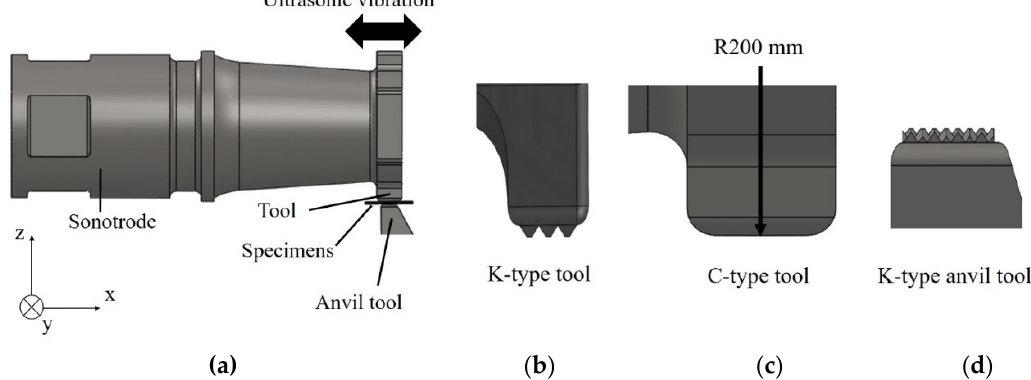
Figure 2. Schematic illustration of ( a ) ultrasonic bonding and tool geometries of the ( b ) knurled tool (K-type), ( c ) cylindrical surface tool (C-type) and ( d ) knurled edge anvil tool.